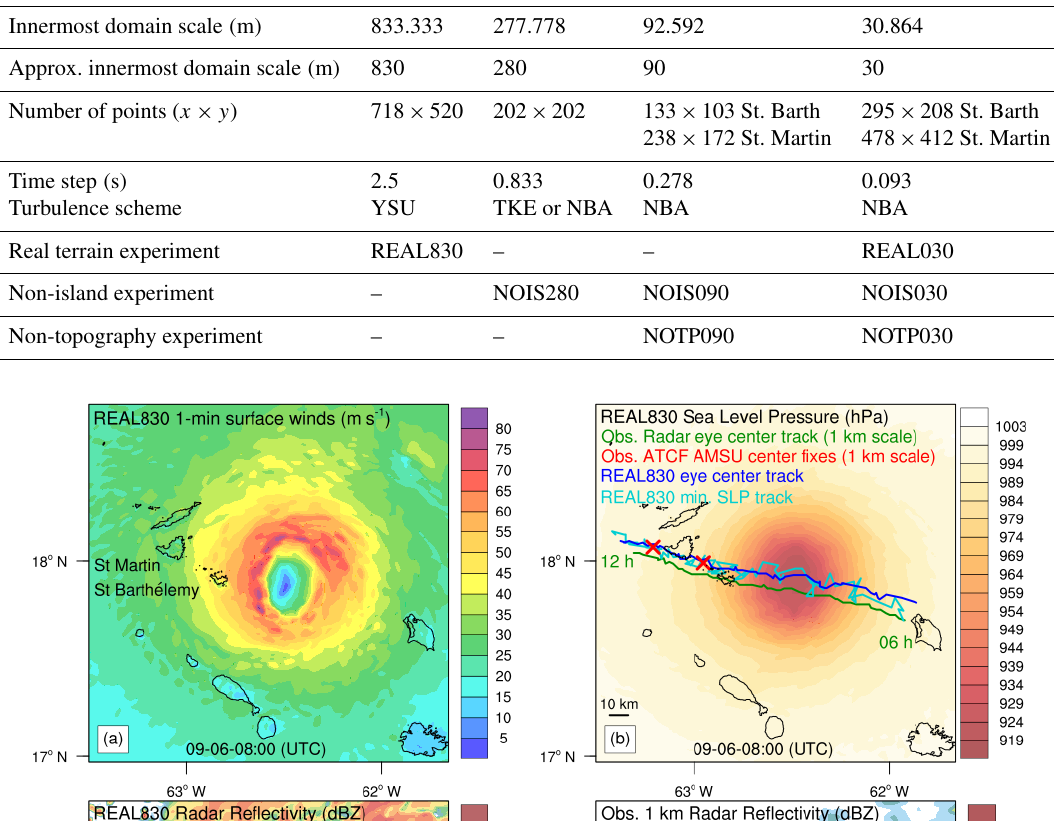
Table 1. Numerical experiments configuration.